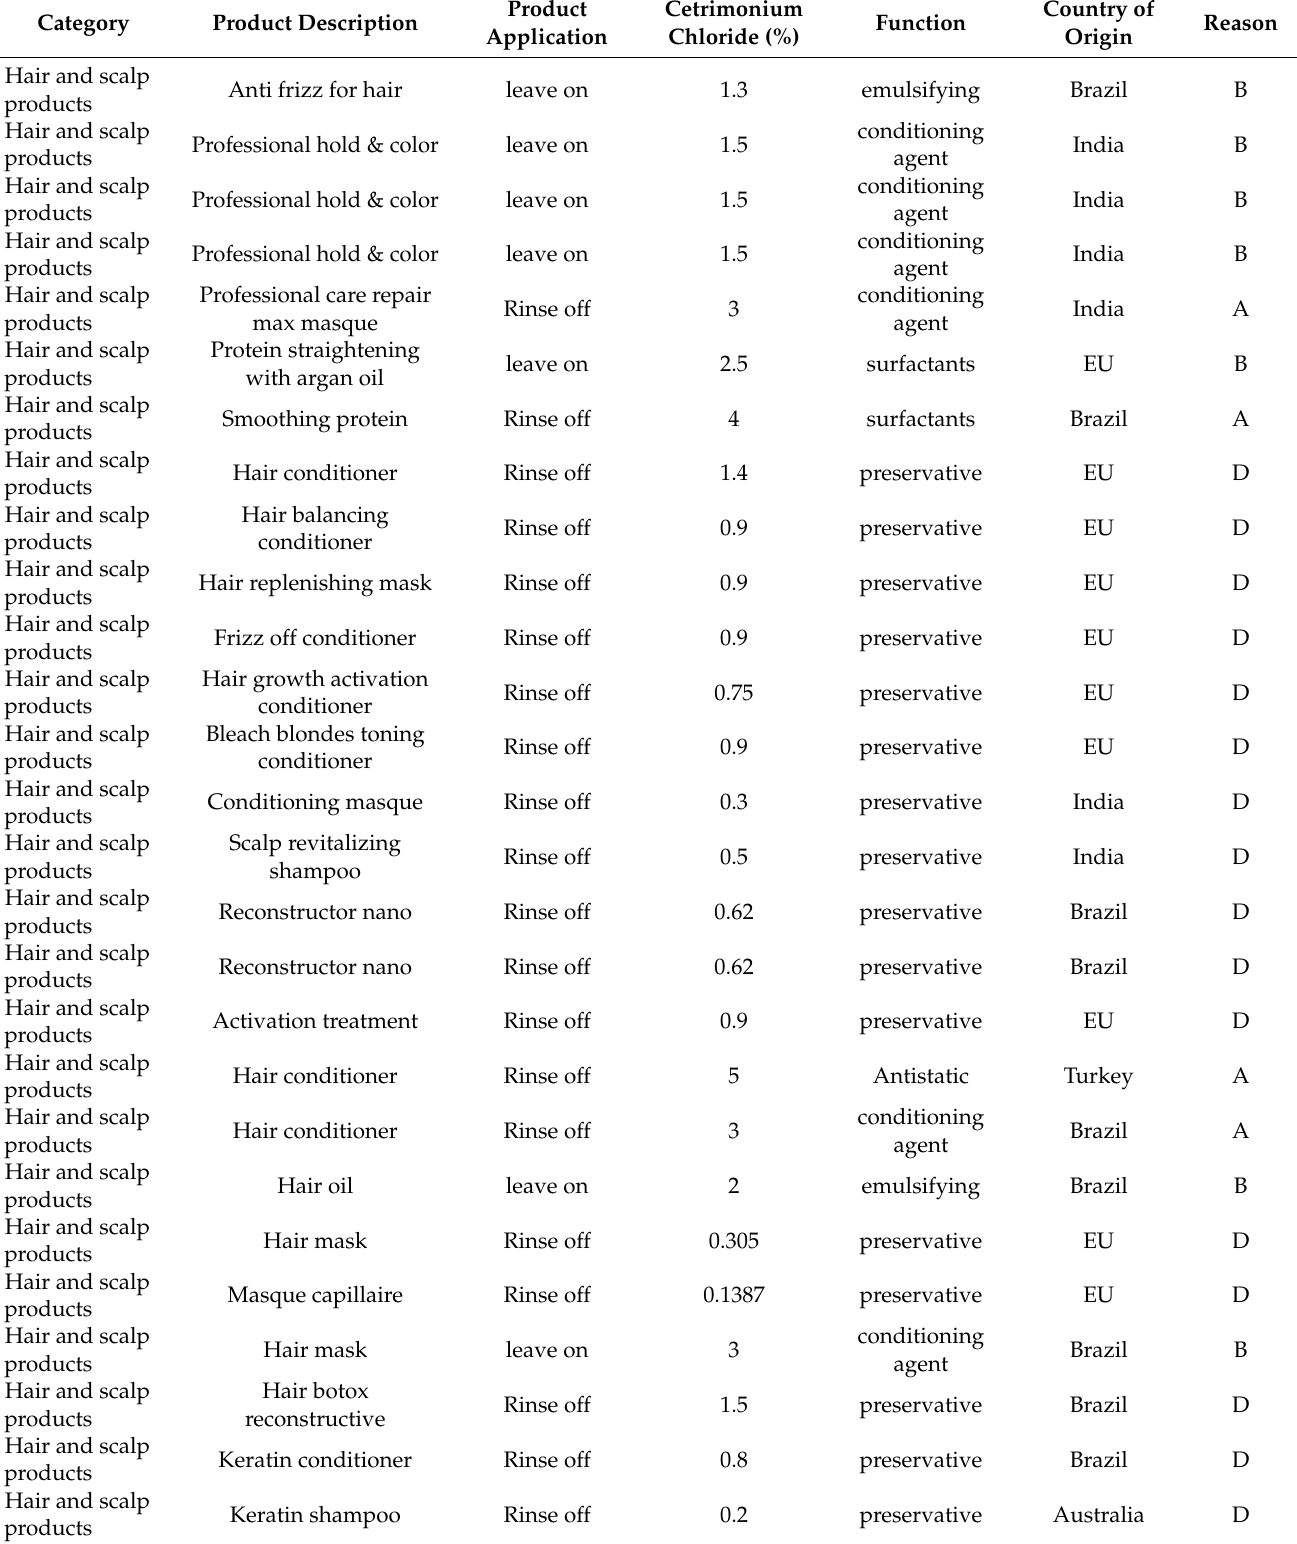
Table 3. List of analyzed cosmetics and personal care products exceeding the maximum allowable limit of Cetrimonium